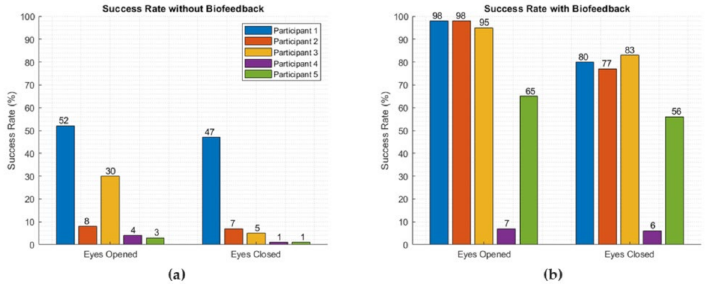
Figure 8. The success rate of static standing experiments with five subjects: ( a ) without soft haptic biofeedback and ( b ) with soft haptic biofeedback